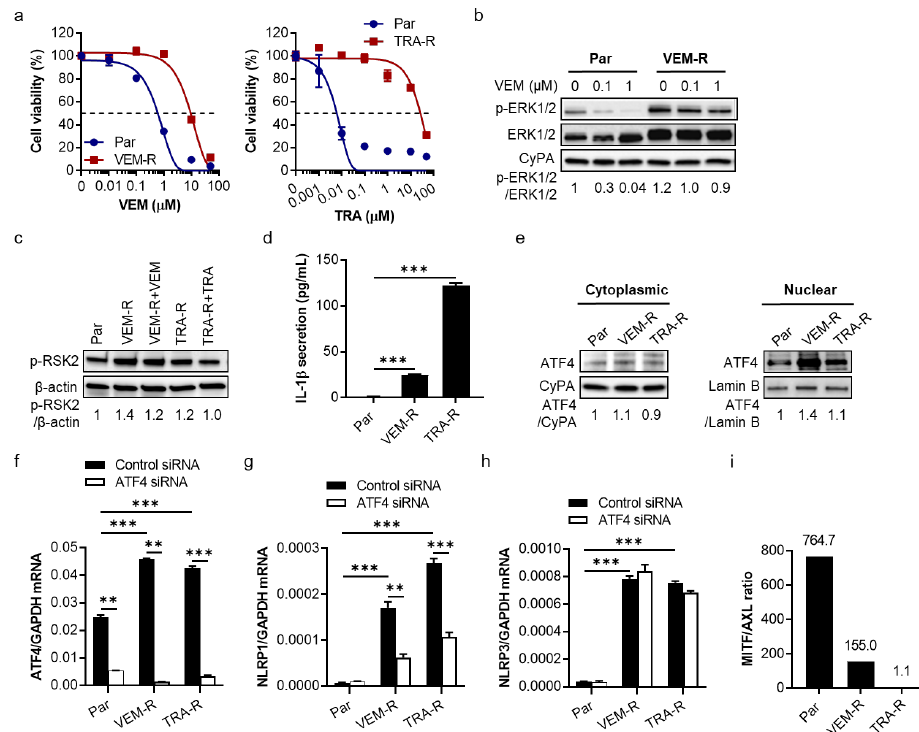
Figure 3. Increased IL-1β secretion, upregulated gene expression of ATF4 and NLRP1, and decreased MITF / AXL ratio in VEM- and TRA-resistant SK-MEL-28 cells. ( a ) Generation of VEM-resistant (VEM-R; left panel ) and TRA-resistant (TRA- R; right panel ) cells by growing cells in the drug-containing medium for 2 months. An increase in 50% inhibitory concen- trations (IC 50 ; dashed line) indicates drug resistance. Par, parental cells. ( b ) Recovered ERK1/2 activation in VEM-R cells treated with 0.1 or 1 µM VEM for 24 h. CyPA, cyclophilin A as a loading control. ( c ) Western blot analysis of RSK2 phos- phorylation in VEM-R and TRA-R cells treated with 1 µM VEM and 0.5 µM TRA, respectively, for 24 h. ( d ) ELISA assay of IL-1β secretion from parental and resistant cells. ( e ) Western blot analysis of intracellular localization of ATF4 in paren- tal and resistant cells. Cytoplasmic and nuclear fractions of cells were isolated and assayed for ATF4 expression with CyPA and Lamin B used as markers for cytoplasmic and nuclear proteins, respectively. ( f – h ) qRT-PCR analysis of ATF4 , NLRP1 , and NLRP3 expression, respectively, in parental and resistant cells transfected with 50 nM control siRNA or ATF4 siRNA overnight. ( i ) The ratios of MITF / AXL gene expression in parental and MAPK inhibitor-resistant SK-MEL-28 cells. In ( b ), ( c ), and ( e ), the band densities of p-ERK1/2, p-RSK2, and ATF4 were quantitated and normalized to those of the corre- sponding total ERK1/2 ( b ), loading controls β-actin ( c ), CyPA or Lamin B ( e ). Representative images are shown and data expressed as the mean ± SEM, n = 3. ** p < 0.01 and *** p < 0.001.